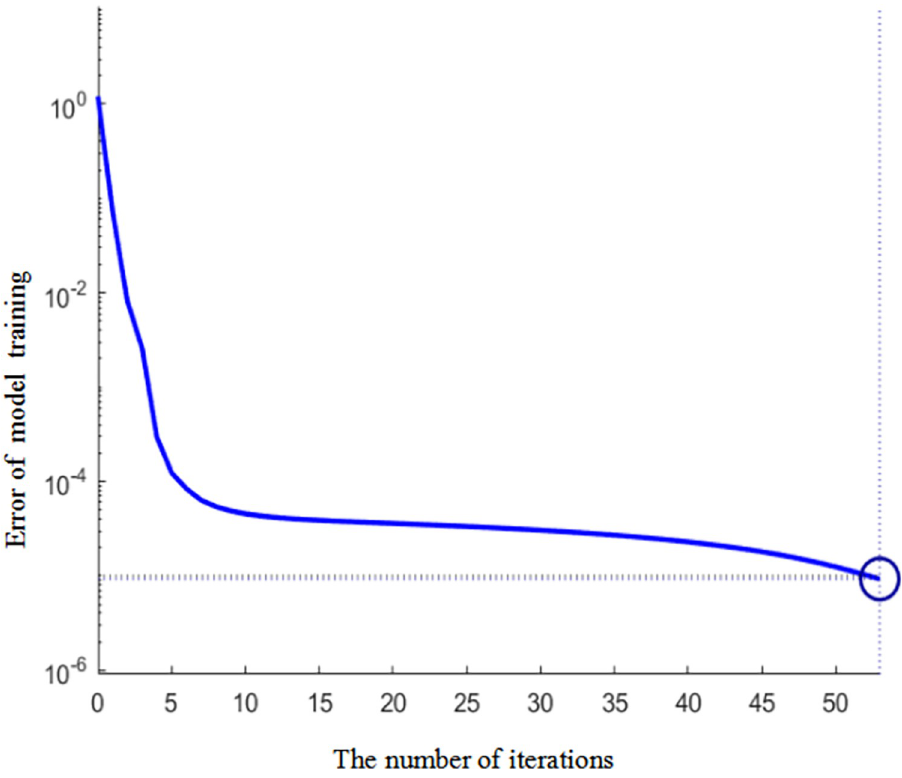
Fig 5. Model training iteration